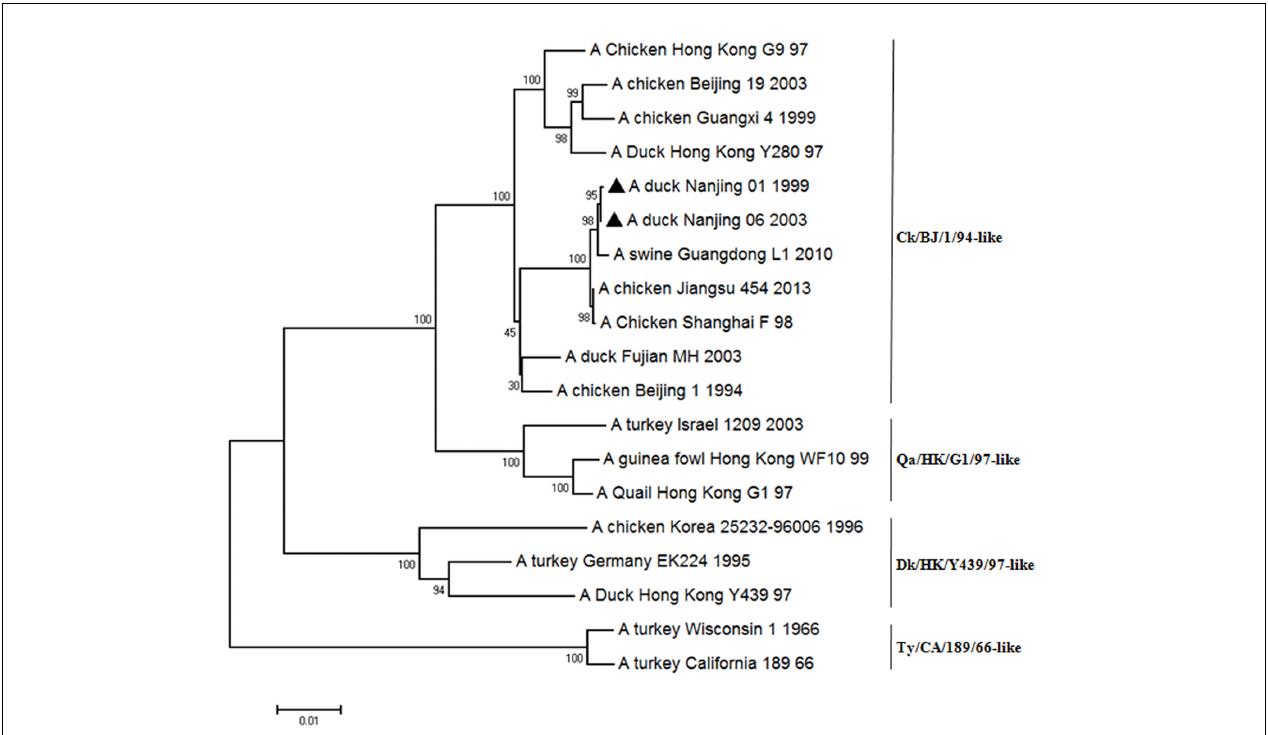
FIGURE 6 | Phylogenetic tree of HA genes of representative H9N2 influenza A viruses. The tree was generated by the distance-based neighbor-joining method using software MEGA 6.06. The reliability of the tree was assessed by bootstrap analysis with 1000 replicates. The viruses tested in this study are marked with black